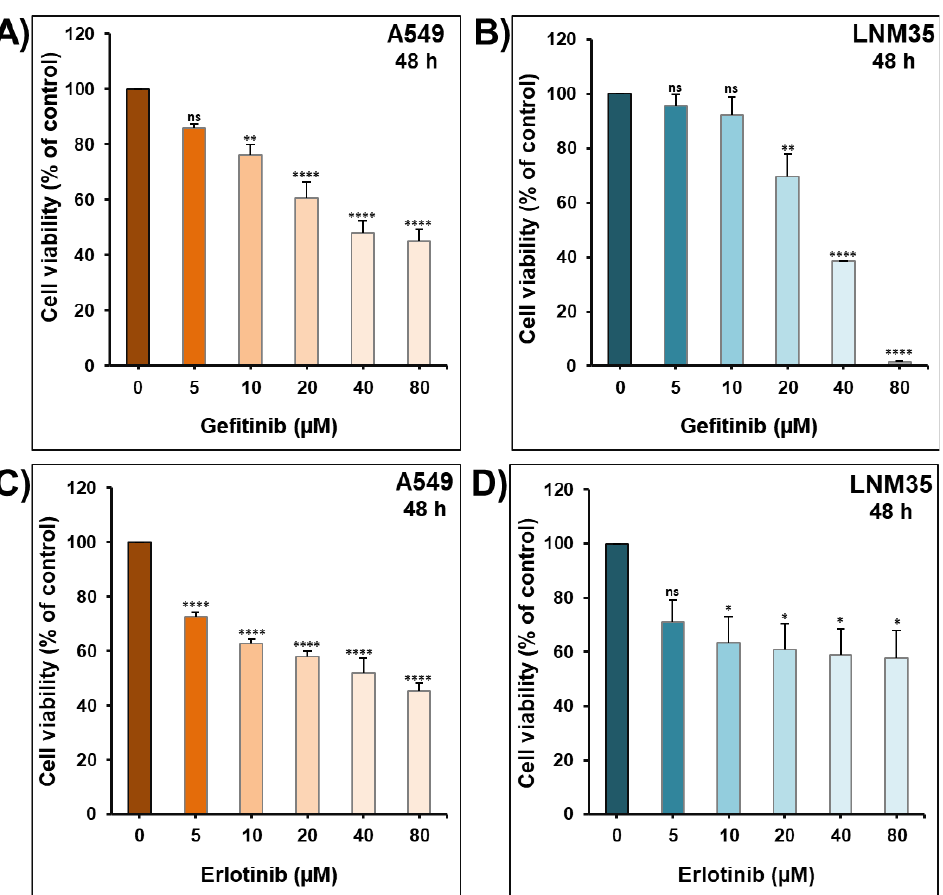
Figure 9. Effect of EGFR-Tki on NSCLC cells’ viability. Exponentially growing A549 ( A , C ) and LNM35 ( B , D ) cells were treated with drug vehicle, gefitinib or erlotinib (5–80 µM) for 48 h. Cellular viability was determined using CellTiter-Glo luminescent assay as described in the Materials and Methods. Experiments were repeated at least 3 times. Columns are means; bars are S.E.M. * Significantly different at <0.05. ** Significantly different at <0.01. **** Significantly different at <0.0001. ns— non-significant.